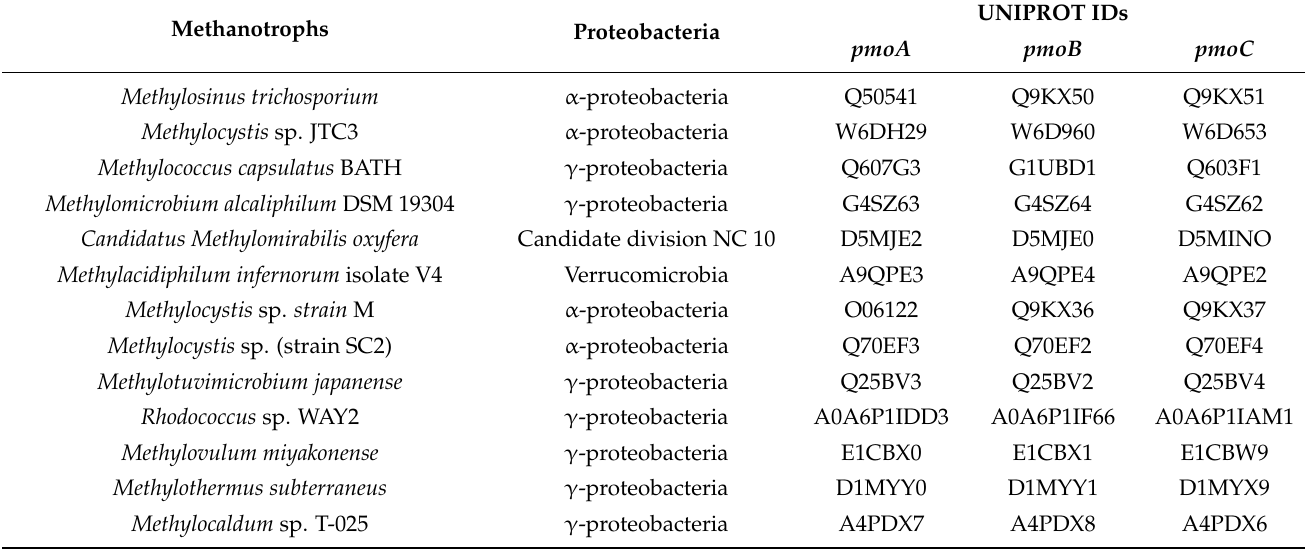
Table 2. UNIPROT IDs of pmoA , pmoB , and pmoC of the listed